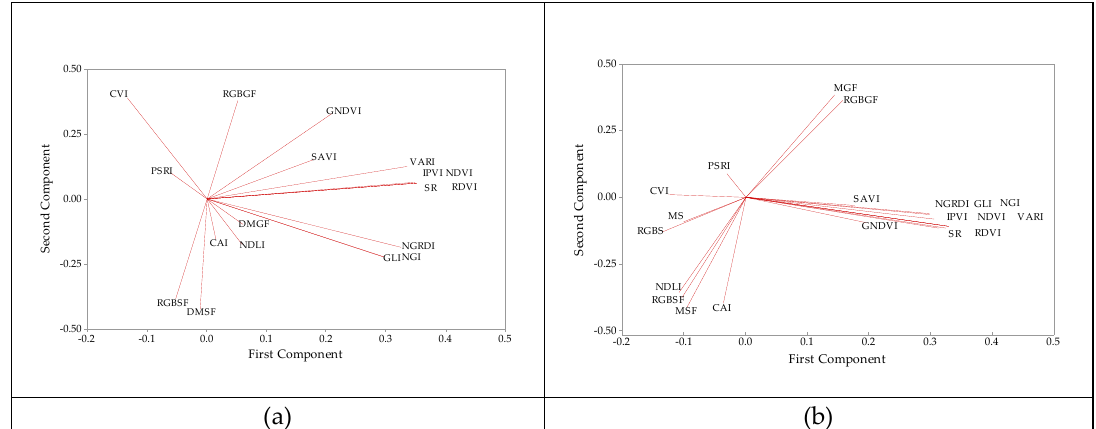
Figure 6. The principal component analysis. The loading plots of the components 1 and 2 obtained from the ground cover fractions and vegetation indices; plot “ a ” shows the preharvest data and plot “ b ” represents the postharvest data. MSF is manual senescent fraction, MGF is manual green fraction, MS is manual soil cover, RGBSF is RGB sensor-based senescent fraction, RGBGF is RGB sensor-based green fraction, and RGBS is RGB sensor-based soil cover. DMSF is the dry matter percentage of the senescent fraction, and DMGF is the dry matter percentage of the green fraction.